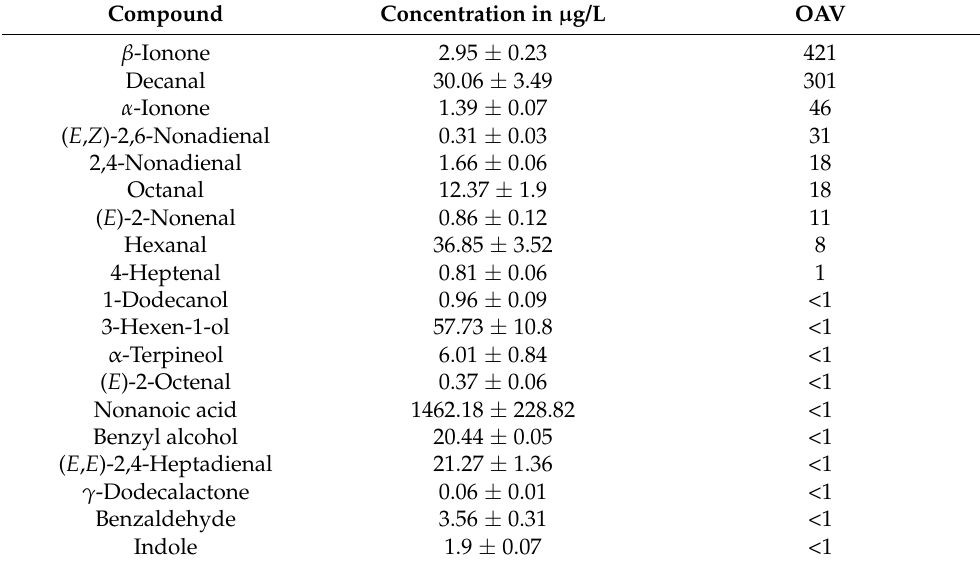
Table A10. Results of semi-quantification and calculated OAVs for sample 930.